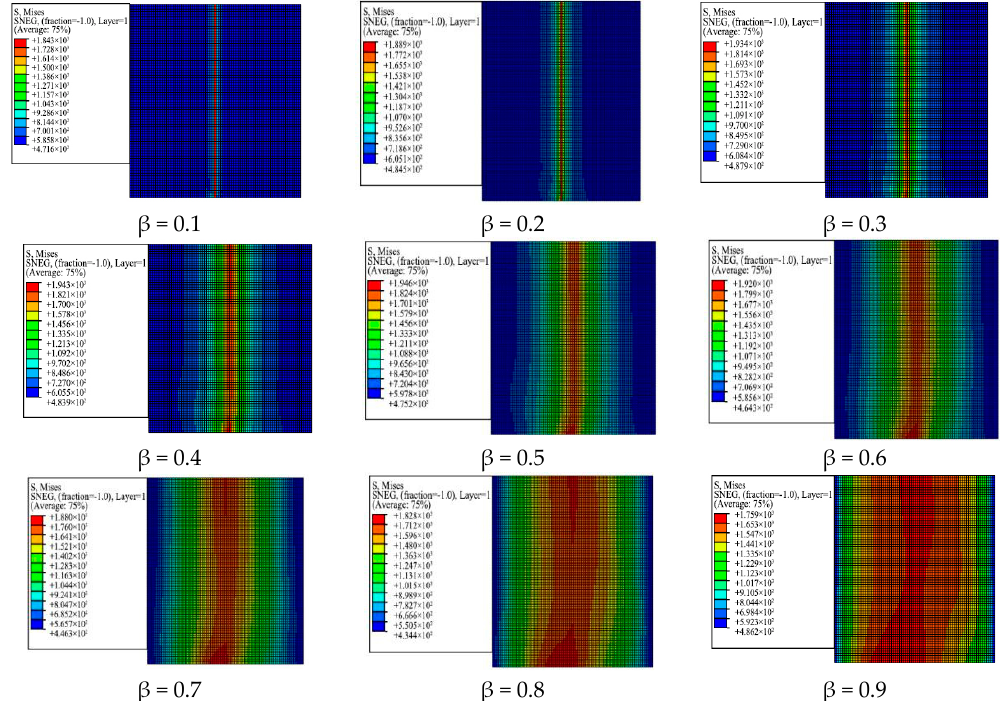
Figure 8. Equivalent stress distribution nephogram of variable-angle laminates of [0 ± < 20 ( β ) 60 >] 2s . Table 2. Maximum-minimum equivalent stress of variable-angle laminates of [0 ± < 20 ( β ) 60 >] 2s .